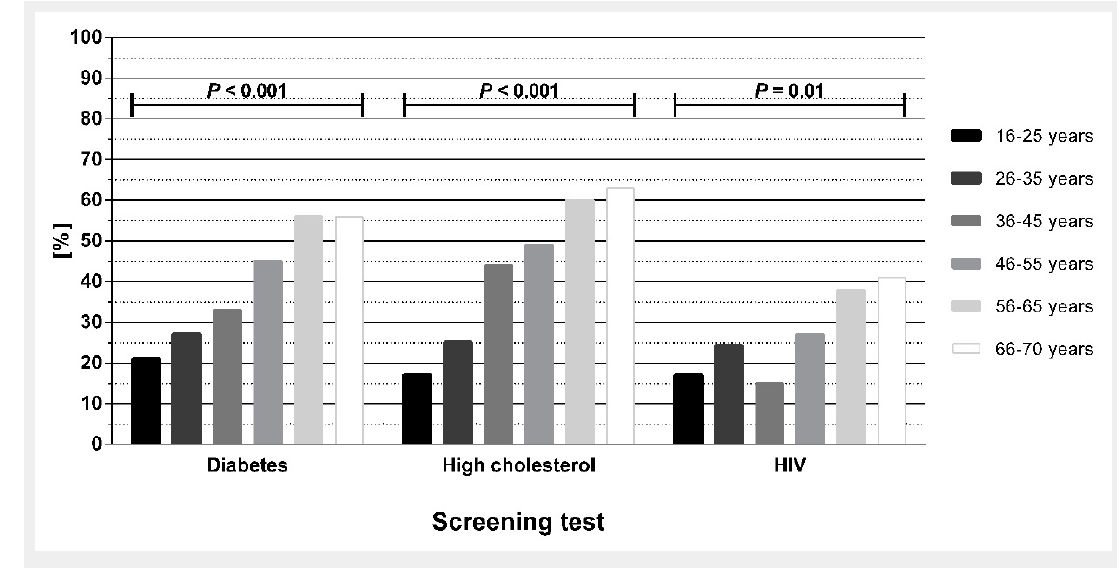
Figure 2 Profile of participating patients, by age, who believed they had been screened for diabetes, high cholesterol and human immunodeficiency virus (HIV) as part of their ED work-up. The p-values are derived from the chi squared test.